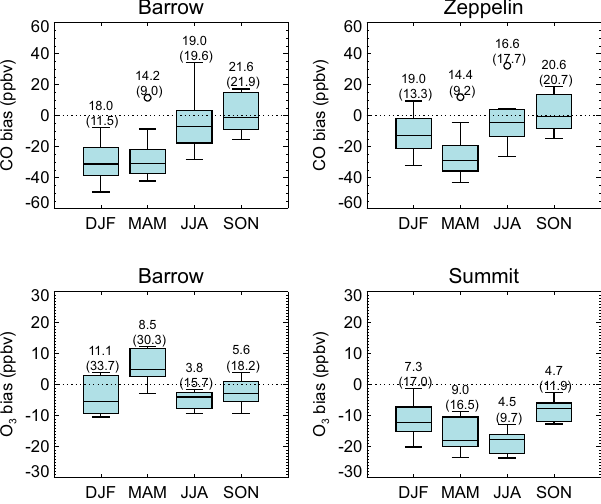
Figure 4. Box and whisker plots showing model seasonal biases (ppbv) for CO at Barrow and Zeppelin (top) and O 3 at Barrow and Summit (bottom). The box and whisker plots show the mini- mum, 25th percentile, median, 75th percentile and maximum values of the sample. The numbers on the plot represent the interquartile range (IQR) of each sample (IQR = 75th–25th percentiles) in abso- lute concentrations and as a percent of observed concentrations (in brackets). Outliers which are more than 1.5 × IQR from the 25th or 75th percentiles are shown by